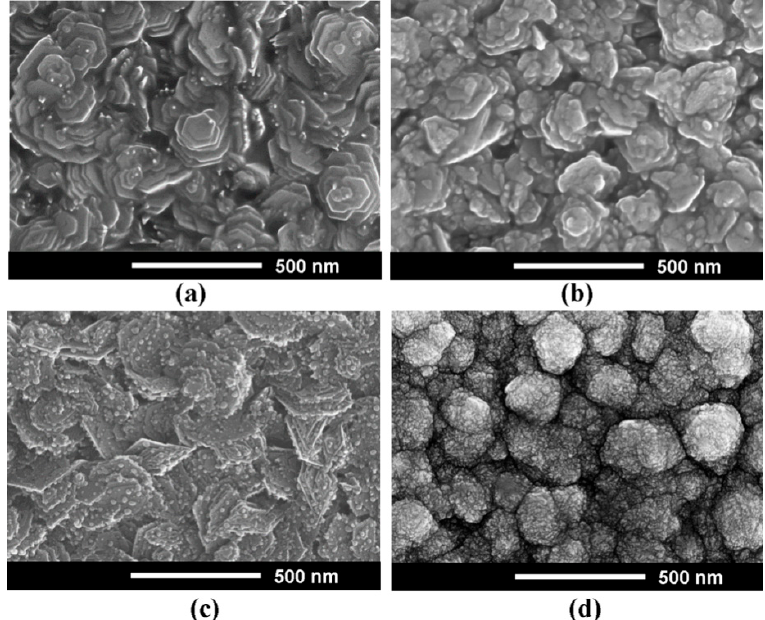
Figure 6. SEM images (top view) of Zn 1 − x Mg x O alloy films deposited by aerosol spray pyrolysis method with the x values of 0.2 ( a ); 0.4 ( b ); 0.6 ( c ); and 0.8 ( d ).